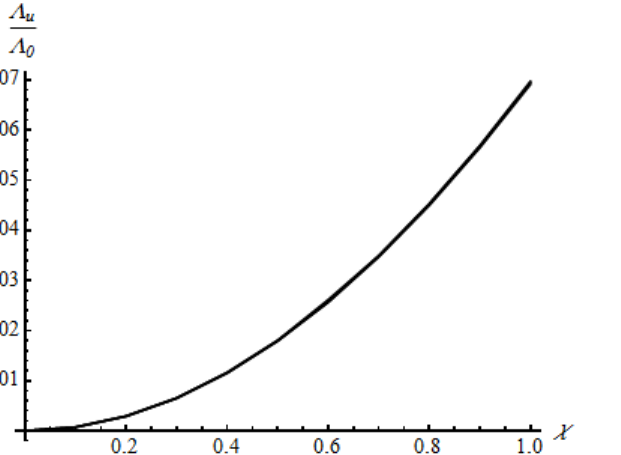
Figure 3. Variation of Λ u / Λ 0 with χ at h = 1. This curve accurately represents Λ u / Λ 0 if the friction Figure 3 . Variation of  with  at 1 h = . This curve accurately represents 0 u factor is within the range 0.7 ≤ m ≤ friction factor is within the range   0.7 1 m . Table 1. Dependence of